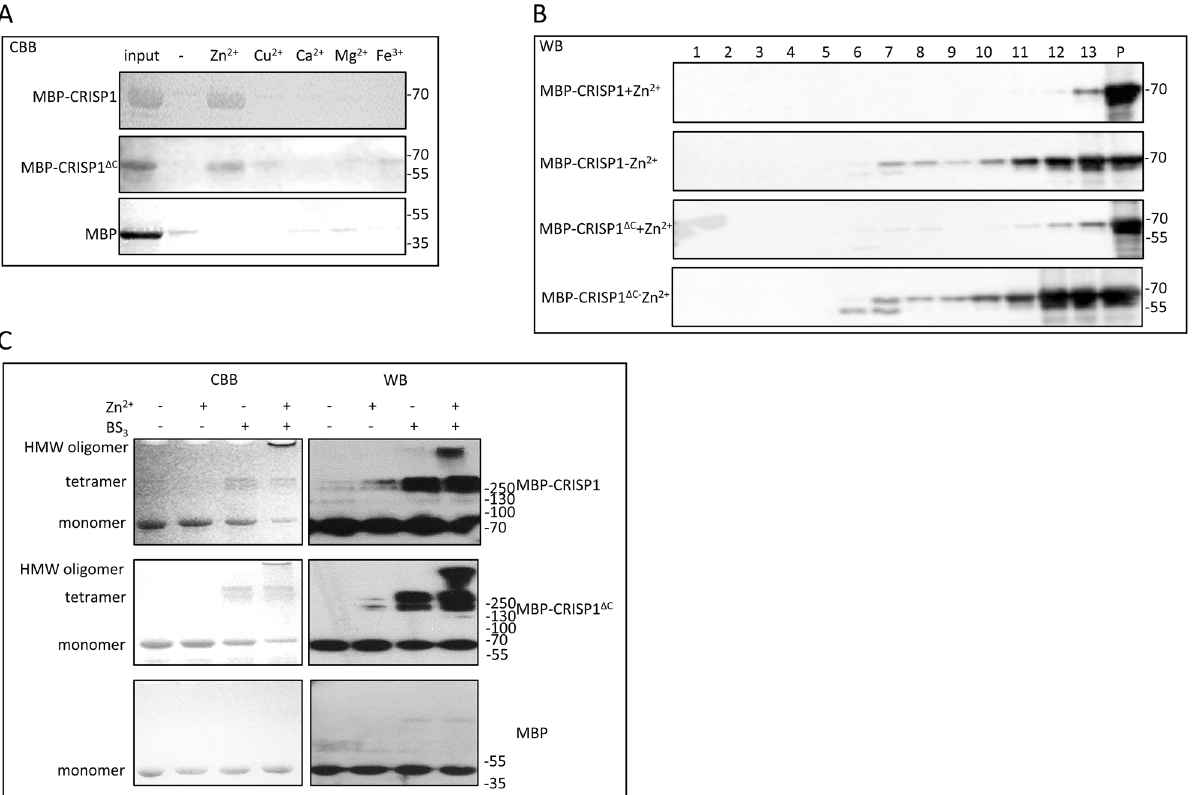
Figure 3. Zn 2+ -induced CRISP1 oligomerization. ( A ) 1.5 μM MBP-CRISP1/MBP-CRISP1 ΔC /MBP was incubated in the absence or presence (1 mM) of various metal ions (Zn 2+ /Cu 2+ /Ca 2+ /Mg 2+ /Fe 3+ as indicated) at 37 °C for 10 min. Samples were spun down at 14,000 g for 1 h at 4 °C. The pellet fraction was analyzed by SDS-PAGE gel and Coomassie Brilliant blue (CBB) staining. ( B ) 1.5 μM MBP-CRISP1/MBP-CRISP1 ΔC was incubated with or without 1 mM Zn 2+ at 37 °C for 10 min. The incubations were then loaded on top of the sucrose gradient. After overnight centrifugation at 210,463 g at 4 °C, 13 fractions (fraction 1 (lowest density) to fraction 13 (highest density)) from the density sucrose gradient were collected, including the pellet (P),